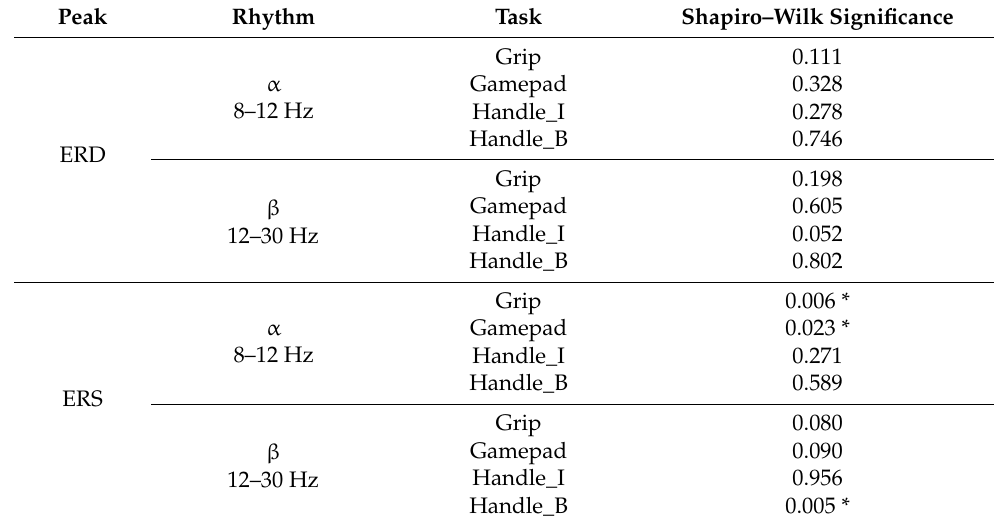
Table 1. Normality tests for the ERD and ERS peak values (* p < 0.05).